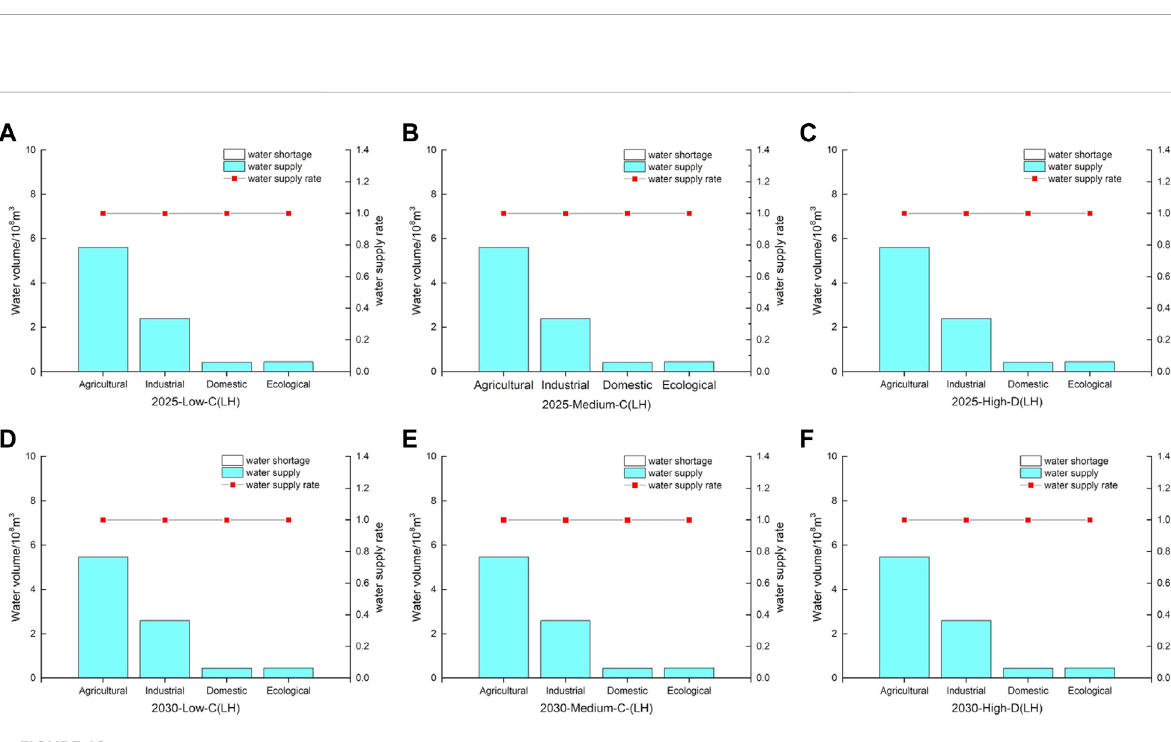
FIGURE 12 Distribution of water resources for six suitable scenarios in Lijin-Hekou section [ (A – F) represent 6 selected scenarios